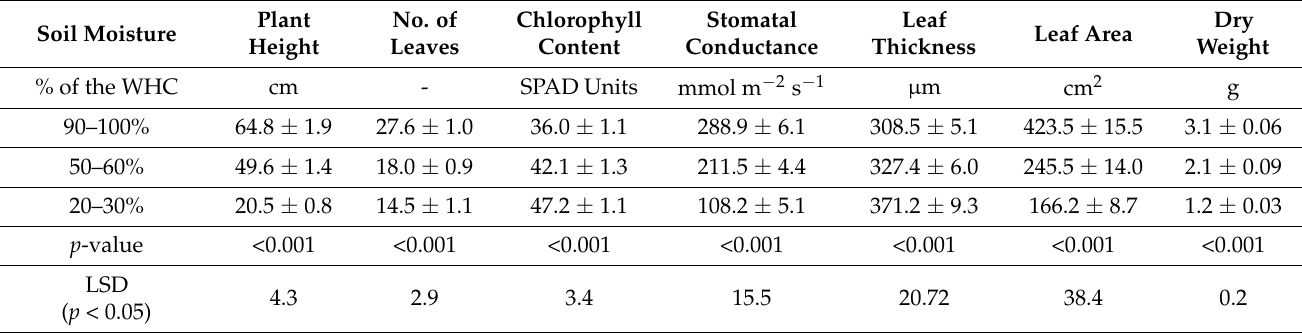
Table 3. Influence of soil moisture regimes on the morpho-physiology and growth of S. oleraceus , measured at 55 to 60 days after emergence. Data collected from repeated experiments with a total of eight replications per treatment. Soil Moisture Leaf Area